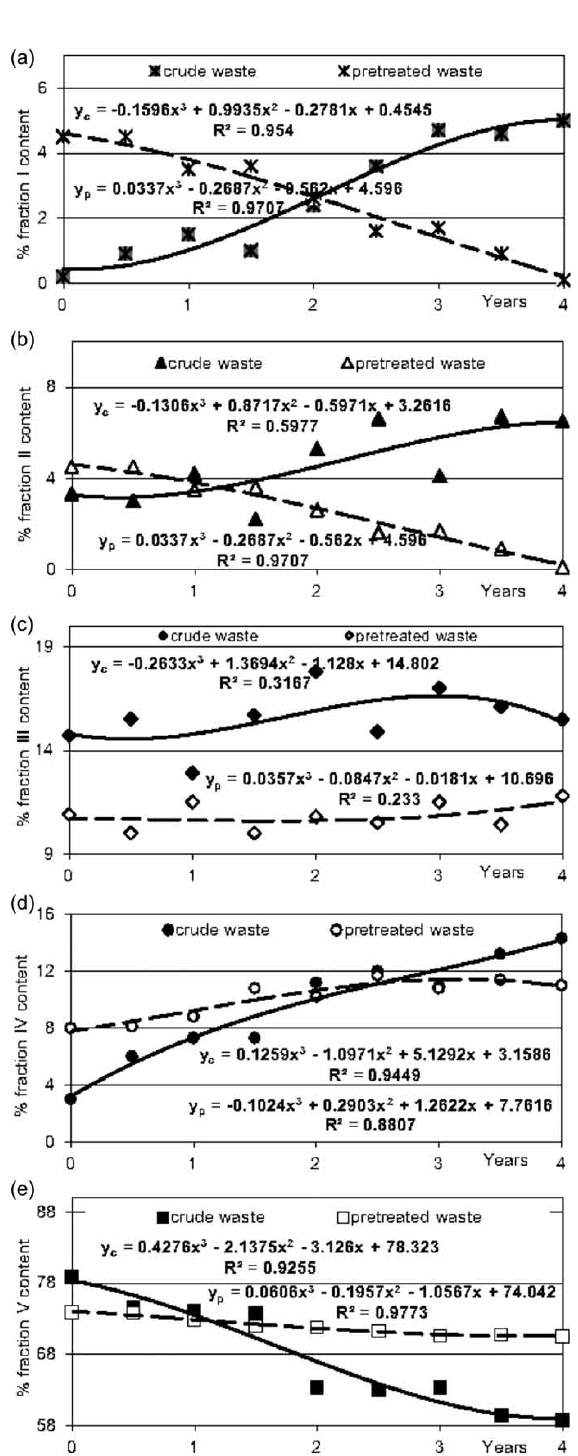
Fig. 6. Changes in the fractional content of lead (Pb) in the surface layer of soil from the experimental plots irrigated and fertilized with mixed wastewaters from an oleo-chemical factory (cid:1) defatted raw (solid line of the trend (cid:1) y c ) and pretreated (broken line of the trend (cid:1) y p ) (C 0(Pb) (cid:1) 10.9 9 1.2 mg/kg d.m.). Individual fractions are given in diagrams: (a) fraction I (cid:1) exchanged, (b) fraction II (cid:1) carbonate, (c) fraction III (cid:1) connected with hydrated oxides of manganese and iron, (d) fraction IV (cid:1) organic, (e) fraction V (cid:1) the